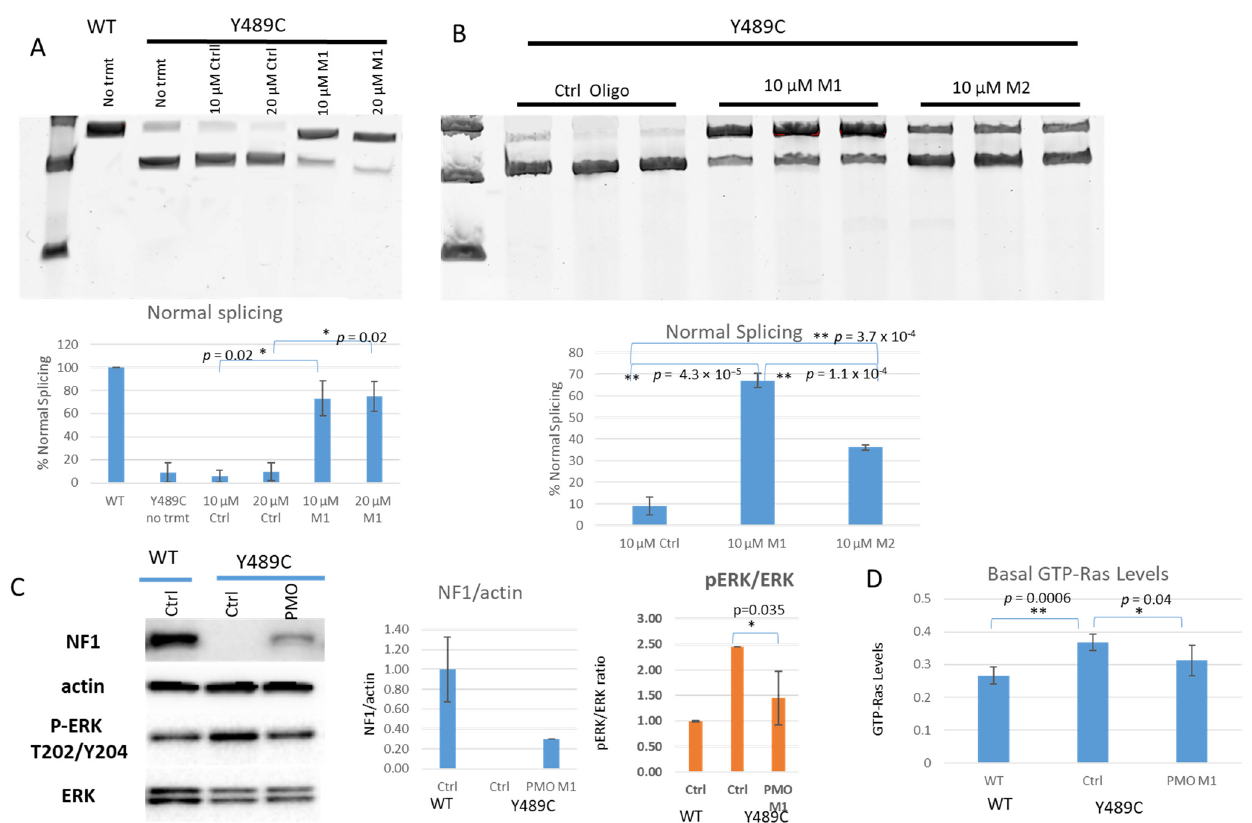
Figure 3. Treatment of Y489C cells with PMOs restores splicing, NF1 protein expression, and function. ( A ) RT-PCR products on representative agarose gel for WT and Y489C containing cells treated with indicated doses of control (Ctrl) and M1 PMO of interest. Histogram below shows quantitation of normal sized transcripts as a function of percentage of total transcript. Notably, M1 is able to significantly restore splicing at both 10 and 20 µ M. Error bars represent SD; N = 3 independent experiments. ( B ) RT-PCR products on agarose gel for Y489C containing cells treated with 10 µ M dose of Ctrl, M1, and M2 PMOs of interest. Histogram below shows quantitation of transcripts. Notably, 10 µ M M1 and M2 are both able to significantly restore splicing, though M1 is significantly more efficient. Error bars represent SD; N = 3 independent experiments. ( C ) Representative Western blot indicating NF1, actin, pERK, and ERK levels of WT and Y489C cells after treatment with Ctrl or PMO M1 at 10 µ M. Histograms depict quantification of N = 3 independent experiments; error bars represent SD. PMO M1 is able to restore NF1 protein expression and lower pERK/ERK ratios. ( D ) Basal GTP-Ras levels for WT and Y489C cells after treatment with Ctrl of PMO M1. Asterisks indicate statistical significance (* p < 0.05; ** p < 0.01).